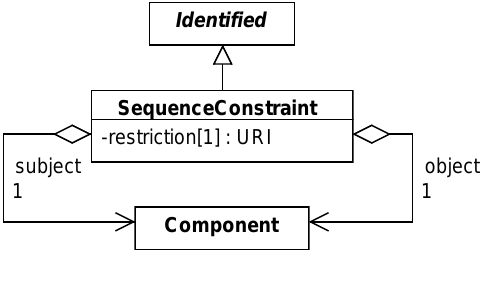
Figure 13: Diagram of the SequenceConstraint class and its associated